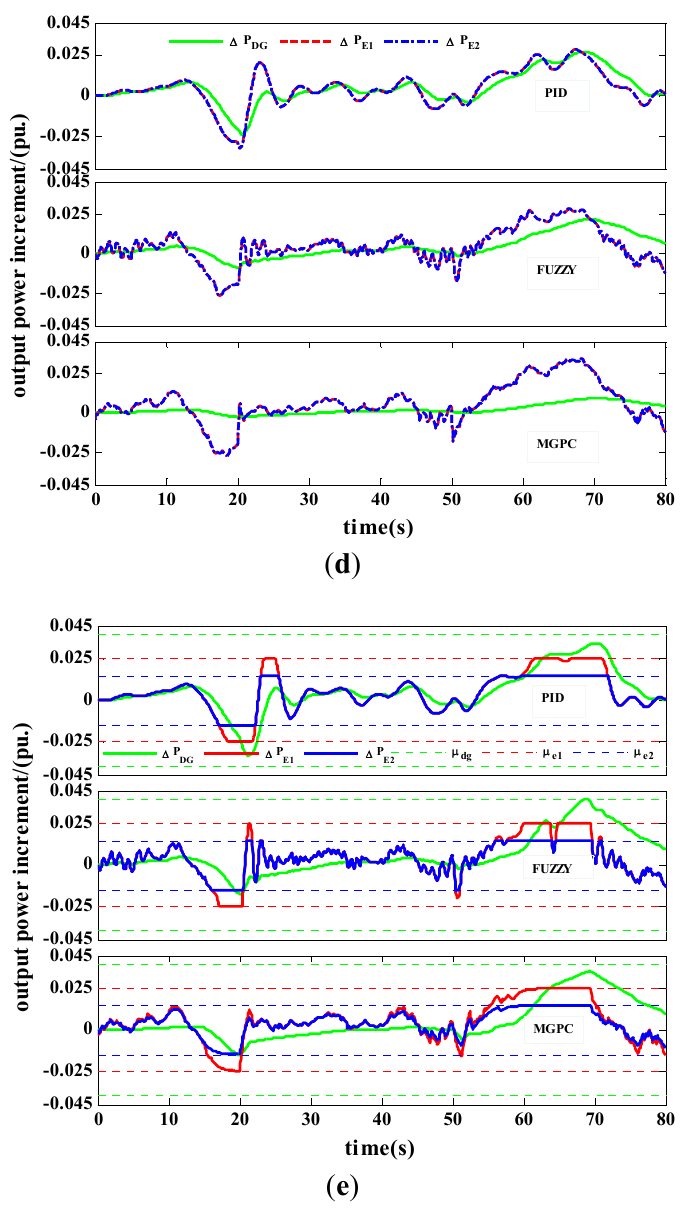
Figure 9. ( a ) The power disturbances applied in case C; ( b ) The frequency deviation of the micro-grid without constraints; ( c ) The frequency deviation of the micro-grid with constraints; ( d ) The output power increment of DG, EV1 and EV2 without constraints; ( e ) The output power increment of DG, EV1 and EV2 with